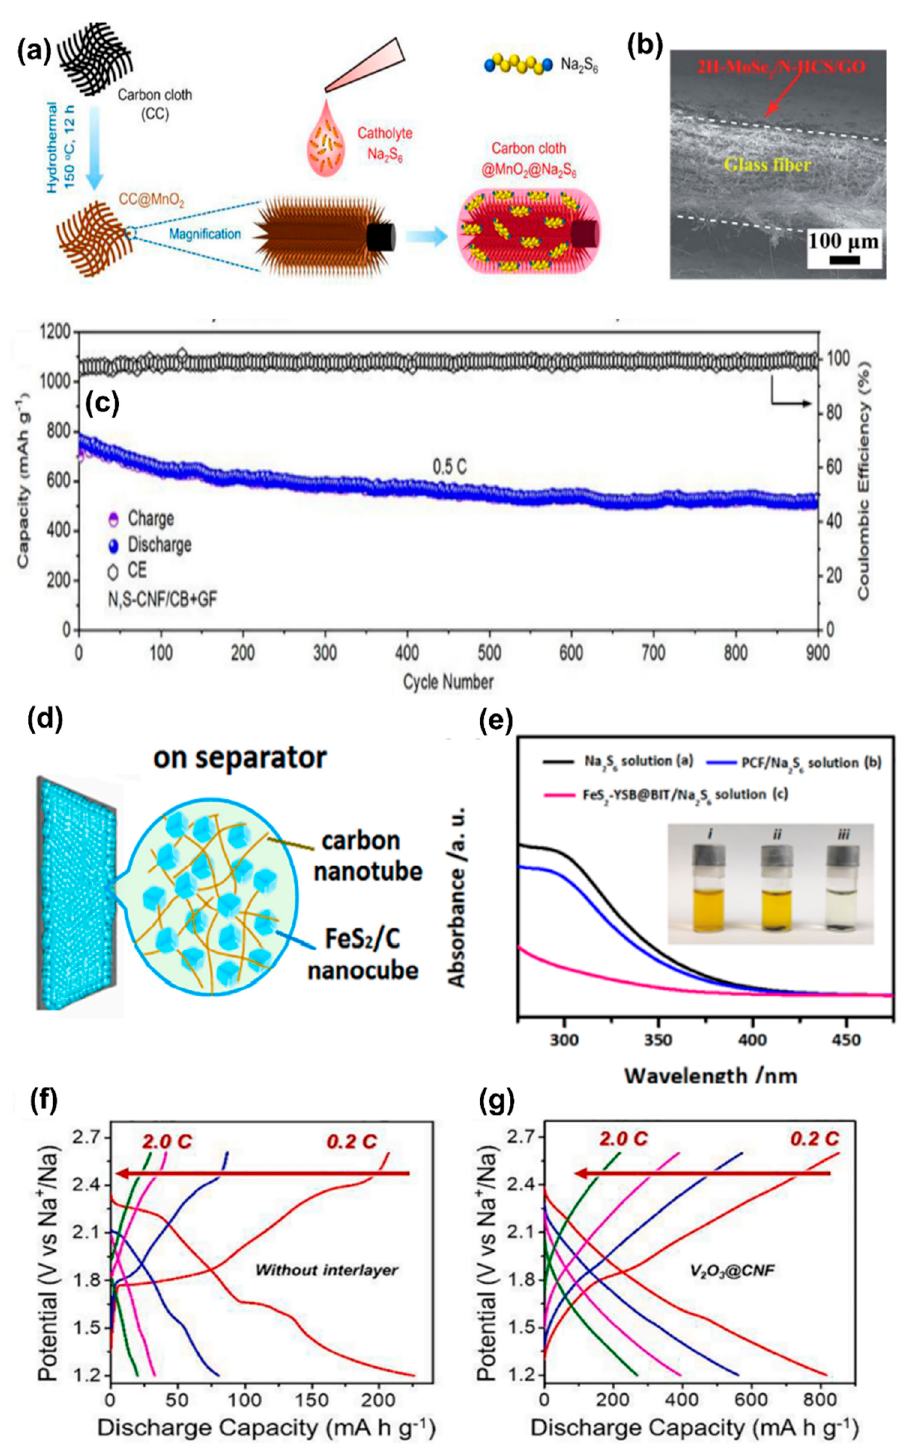
Figure 6. ( a ) CC@MnO 2 @Na 2 S 6 cathode. Reproduced with permission [66]. Copyright 2019, Elsevier. ( b ) FE-SEM image of MoSe 2 /N-HCS/GO-coated glass fiber (GF) separators. Reproduced with permission [53]. Copyright 2021, Royal Society of Chemistry. ( c ) Cycle performance RT-Na/S battery with an N, S-CNF/CB+GF separator. Reproduced with permission [108]. Copyright 2022, Elsevier. ( d ) Scheme of FeS 2 /C nanocube/CNT-coated GF separators and ( e ) demonstration of NaPS adsorption capability. Reproduced with permission [81]. Copyright 2021, Elsevier. Voltage profiles of RT-NaSBs ( f ) without interlayer and ( g ) with V 2 O 3 @CNF interlayer. Reproduced with permission [109]. Copyright 2021,